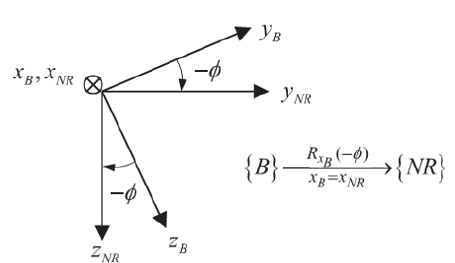
Figure 1. Transformation from rolling frame {B} to non-rolling frame